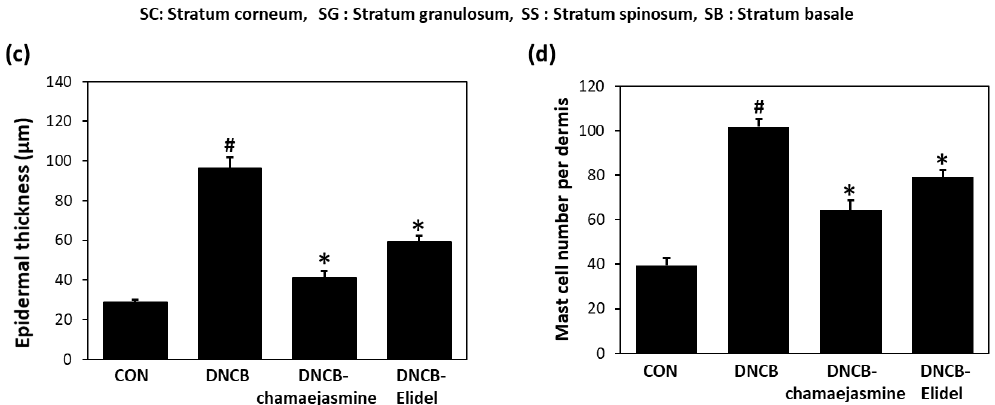
Figure 5. Effects of chamaejasmine on histopathological changes, epidermal thicknesses, and mast cell numbers in DNCB-induced AD-like skin lesions in SKH-1 hairless mice. ( A ) H&E staining, ( B ) toluidine blue staining, ( C ) epidermal thicknesses and ( D ) mast cell numbers. Results are expressed as the means ± SEMs of two independent experiments. # P < 0.05 vs. the CON group; * P < 0.05 vs. the DNCB group. CON: vehicle control group, DNCB: DNCB-treated control group, DNCB-chamaejasmine: DNCB and 0.5% chamaejasmine-treated group, DNCB-Elidel: DNCB and 1% pimecrolimus cream-treated group.